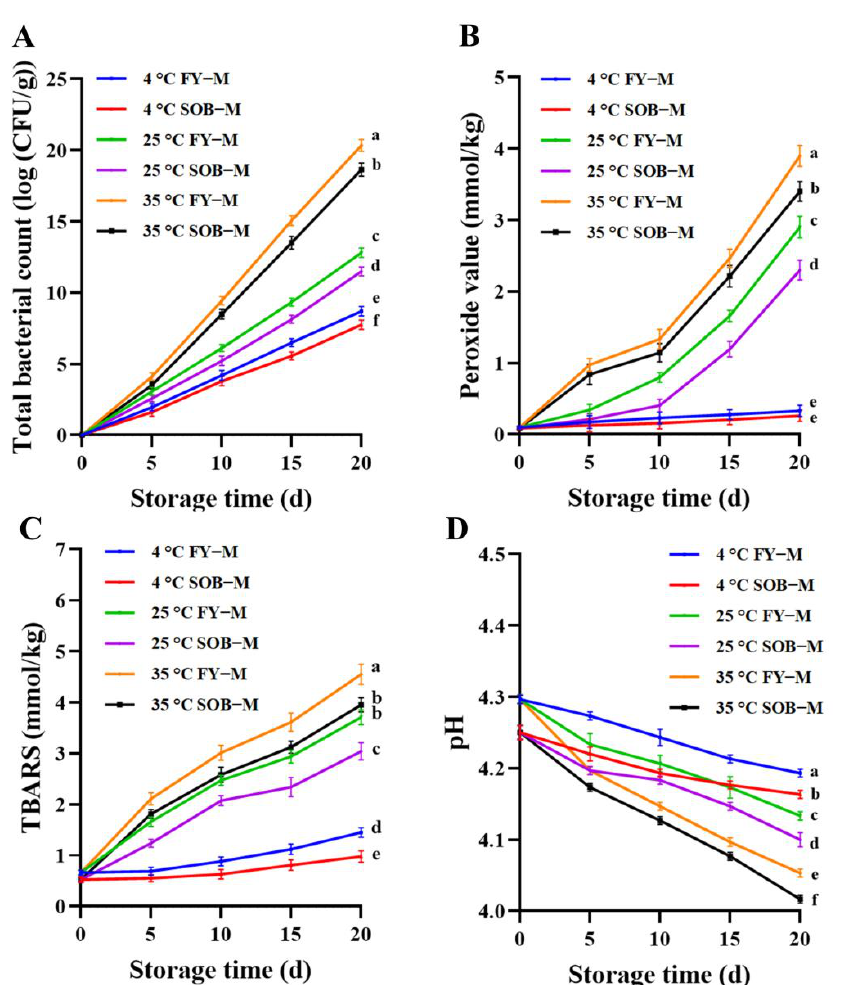
Figure 3. The ( A ) total bacteria count, ( B ) peroxide value, ( C ) thiobarbituric acid reactive substance, and ( D ) pH of full egg yolk mayonnaise (FY − M) and SOB-substituted mayonnaise (SOB − M) during storage. Different lowercase letters indicated significant difference ( p < 0.05).